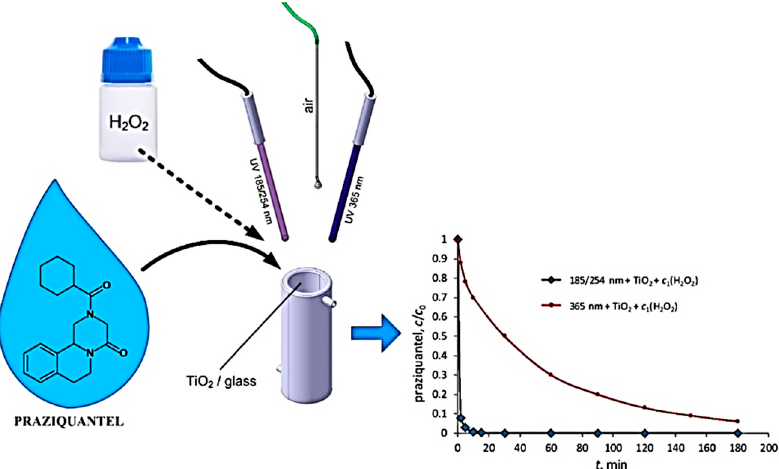
Figure 8. Schematic representation of photodegradation of PZQ using UV light, TiO 2 material, and H 2 O 2 in oxidative photolysis processes. Reprinted/adapted with permission from Ref. [140]. Copyright 2017 Elsevier.